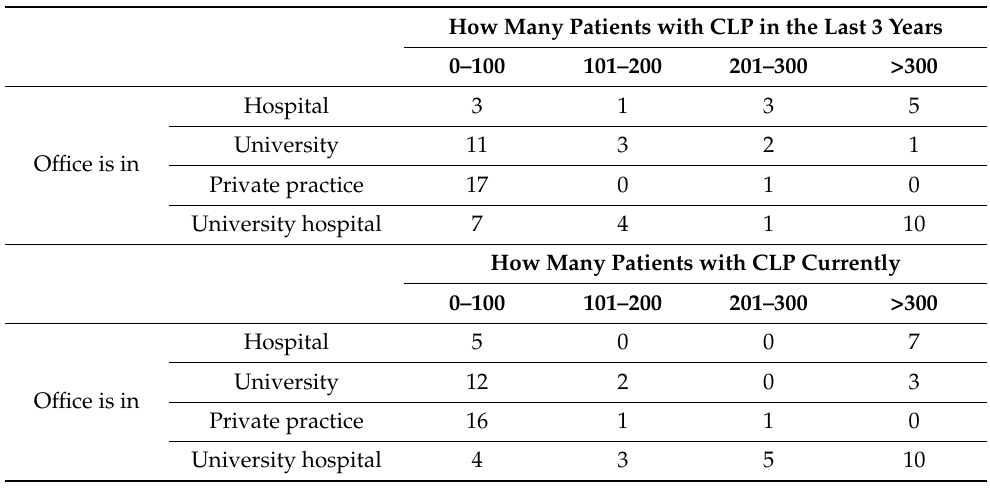
Table 2. Survey results on distribution of patients with CLP by office environment.